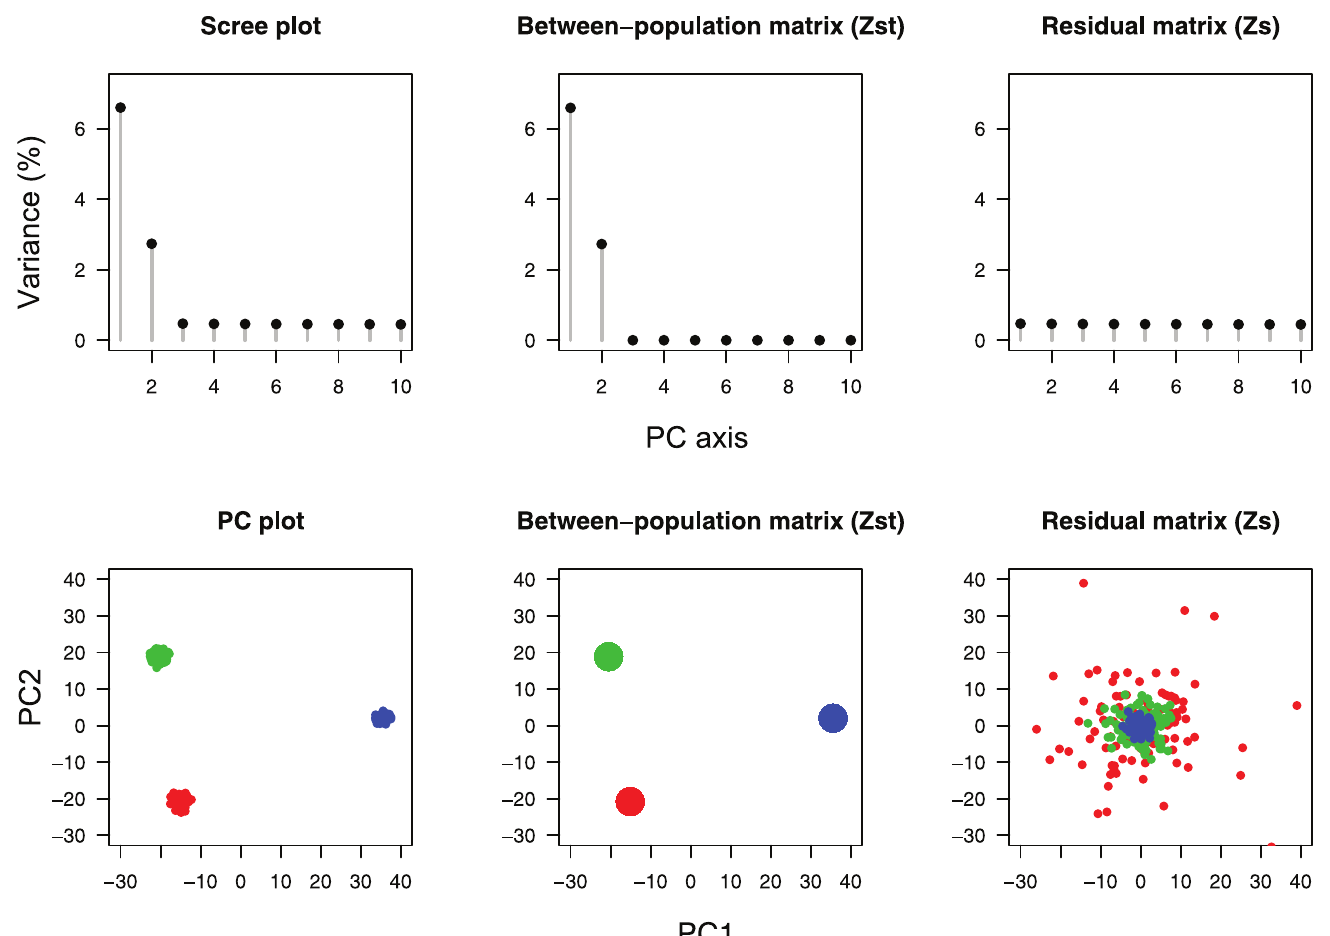
Fig 1. Spectral analysis of a three-population model. PCA scree plots and PC plots for the scaled matrix, Z sc , for the between-population matrix, Z sc residual matrix, Z sc of simulated data. The simulation was performed for n = 300 individuals and an F -model ( F 1 = 5%, F 2 = 10%, F 3 = 30%) with ancestral S frequency drawn from a beta(1,4) distribution.